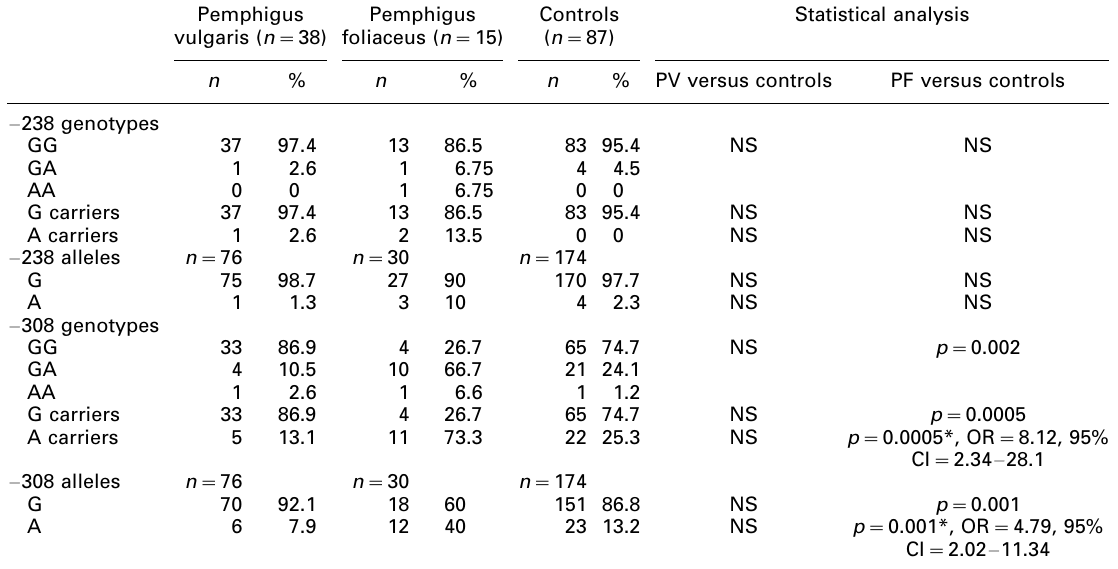
Statistical analysis